Question: What type of chart is this?
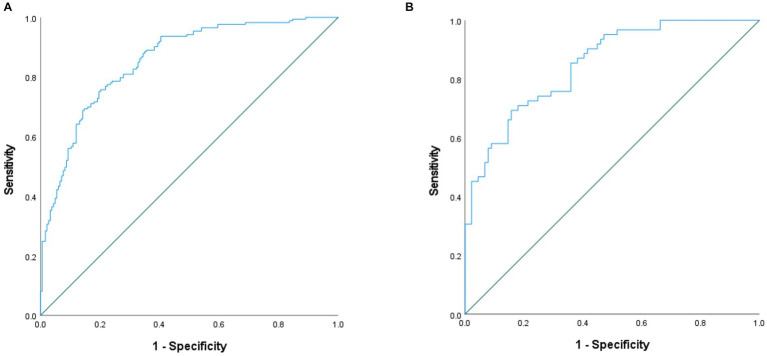
Answer: line